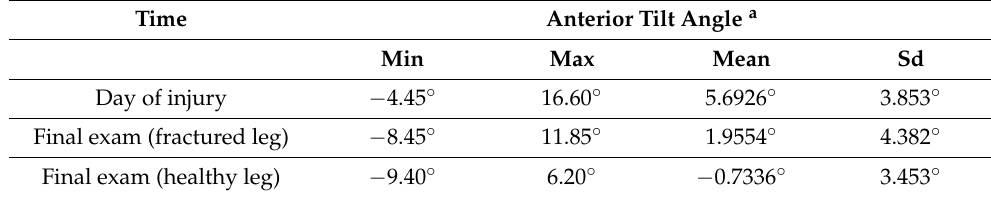
Table 3. Summary statistics of anterior tilt angle measurements in children with trampoline fracture of the tibia who received radiographs of the healthy leg on the day of the injury and at least one year after trauma ( n = 72/89). Time Anterior Tilt Angle a Min